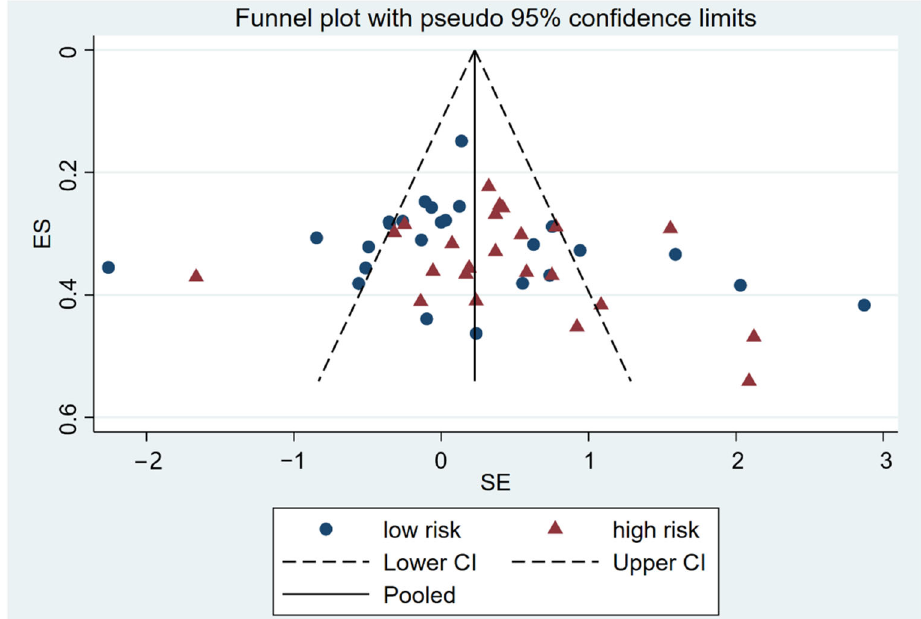
Figure 3. Meta ‐ funnel plotted in the first reported continuous results in the meta ‐ analysis for each trial against their standard errors. Different colors indicate different sponsor categories. The outer dashed lines indicate the triangular region within which 95% of studies are expected to lie in the absence of both biases and heterogeneity.